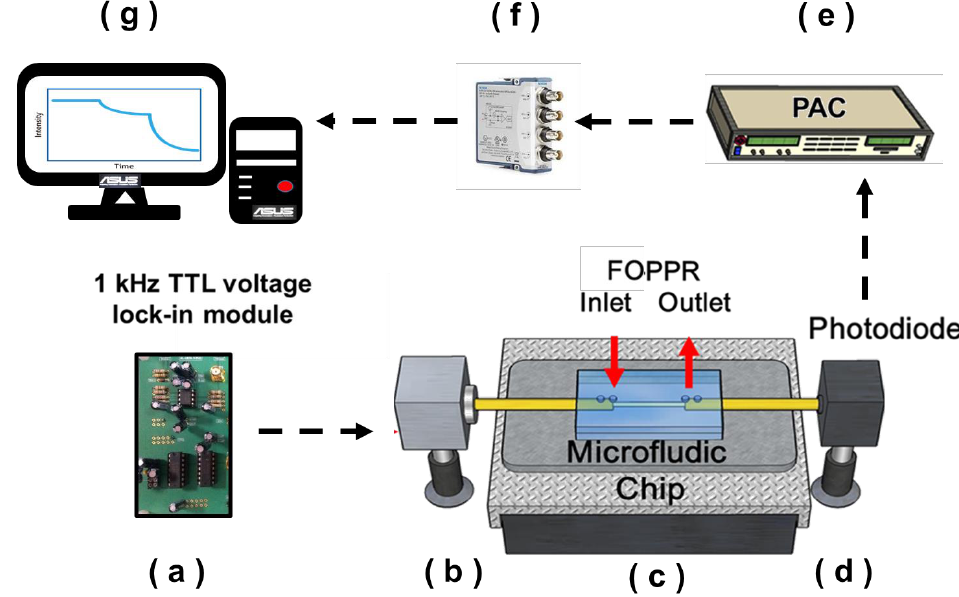
Figure 2. Schematic representation of the experimental setup used for the fiber optic particle plasmon resonance (FOPPR) biosensor. The setup consists of ( a ) a light emitting diode (LED) driver circuit; ( b ) a light emitting diode; ( c ) a microfluidic chip; ( d ) a photodiode; ( e ) a photoreceiver amplification circuit; ( f ) a data acquisition card and ( g ) a computer.